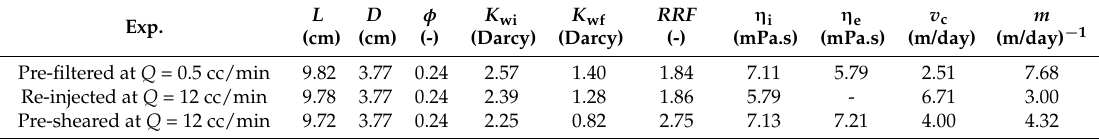
Table 4. Core and solution properties for injected Solution A (Concentration = 500 ppm, MW = 18 MDa). Exp.